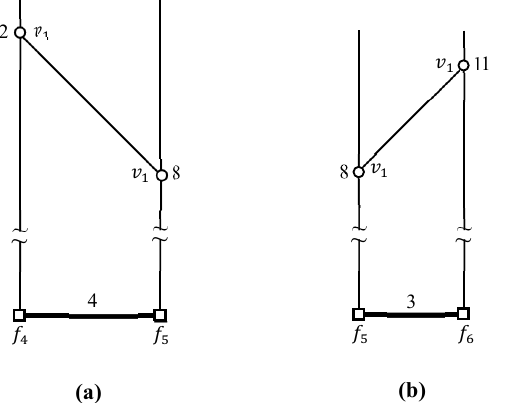
Figure 7. d max ( v 1 , { f 4 f 5 , f 5 f 6 } ) = 12 and d min ( v 1 , { f 4 f 5 , f 5 f 6 } ) = 8; ( a ) d max ( v 1 , f 4 f 5 ) = 12 and